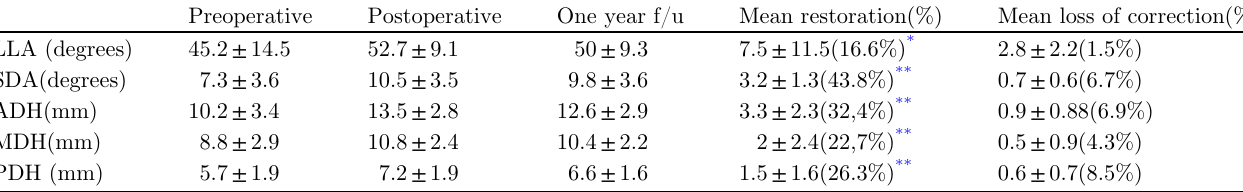
Table 1. Radiological results.